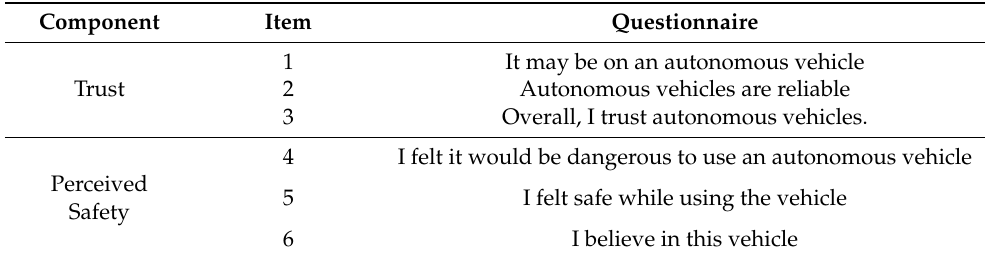
Table 1. Trust [21] and Perceived Safety [22]: Questionnaire